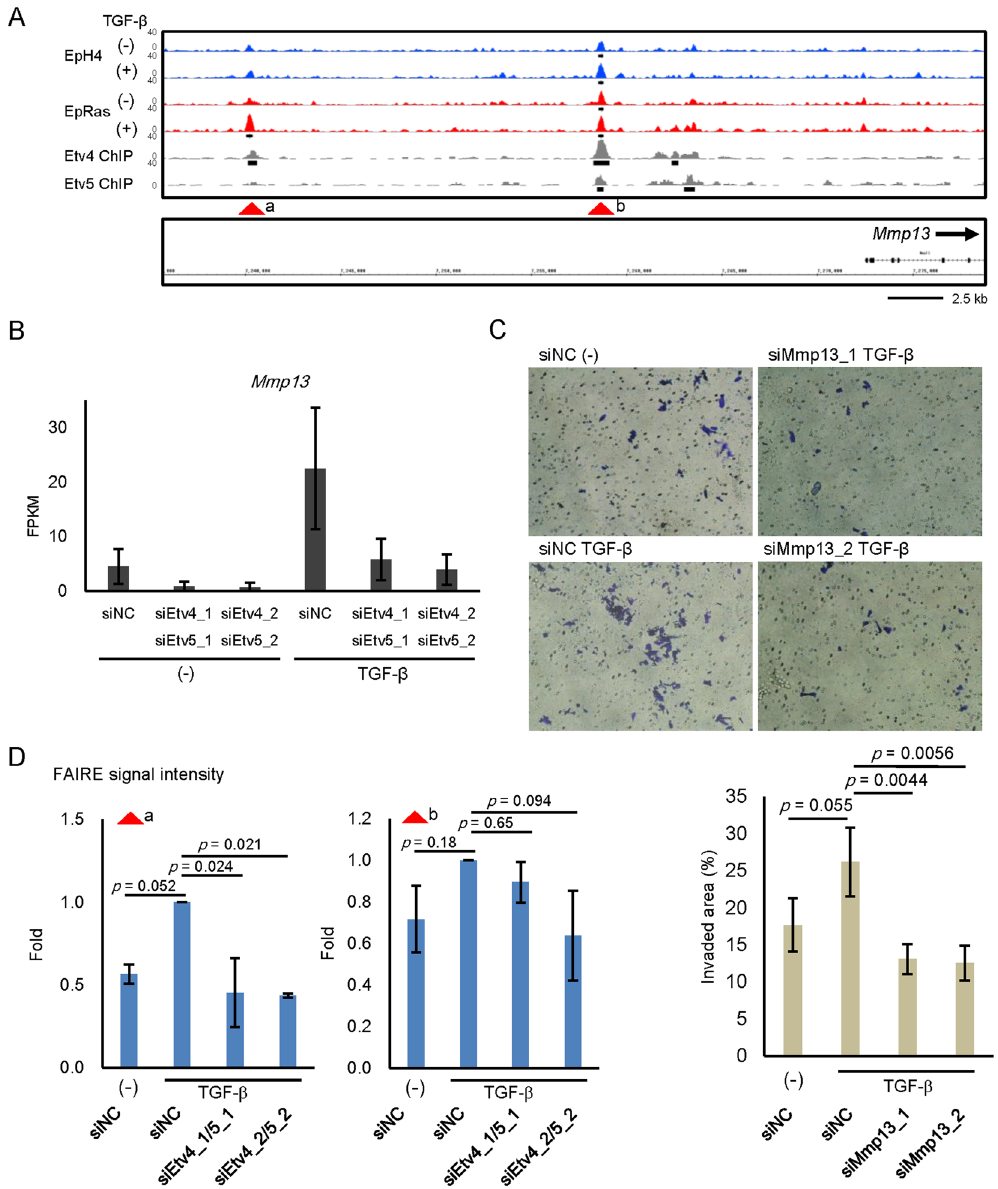
Figure 6. Regulation of Mmp13 expression by Etv4 and Etv5. ( A ) FAIRE-seq and ChIP-seq data at the matrix metalloproteinase 13 ( Mmp13 ) gene locus as a target of Etv4 and 5. Data are shown as in Figs 2A and 4E. Arrow heads show the positions evaluated by FAIRE-qPCR in ( D ). ( B ) RNA-seq data of siEtv4/5-transfected EpRas cells treated with TGF- β . siNC; negative control siRNA. Error bars, 95% confidence intervals. ( C ) Matrigel invasion assay in EpRas cells. Cells were transfected with the indicated siRNAs and then seeded on the Matrigel- coated plate, incubated for 48 h with TGF- β , and fixed. (upper panels) Representative images of the cells that migrated through the Matrigel-coated membrane. (bottom graph) Quantified data representing the means of four independent experiments. Error bars, standard deviations. ( D ) Changes in the FAIRE-seq signal intensities by Etv4/5 siRNAs at FAIRE-positive regions of Mmp13 gene locus shown in ( A ). EpRas cells transfected with the indicated siRNAs were treated with TGF- β for 4 days and fixed for FAIRE-seq data acquisition. The data represent the result of two biological replicates. Error bars, standard